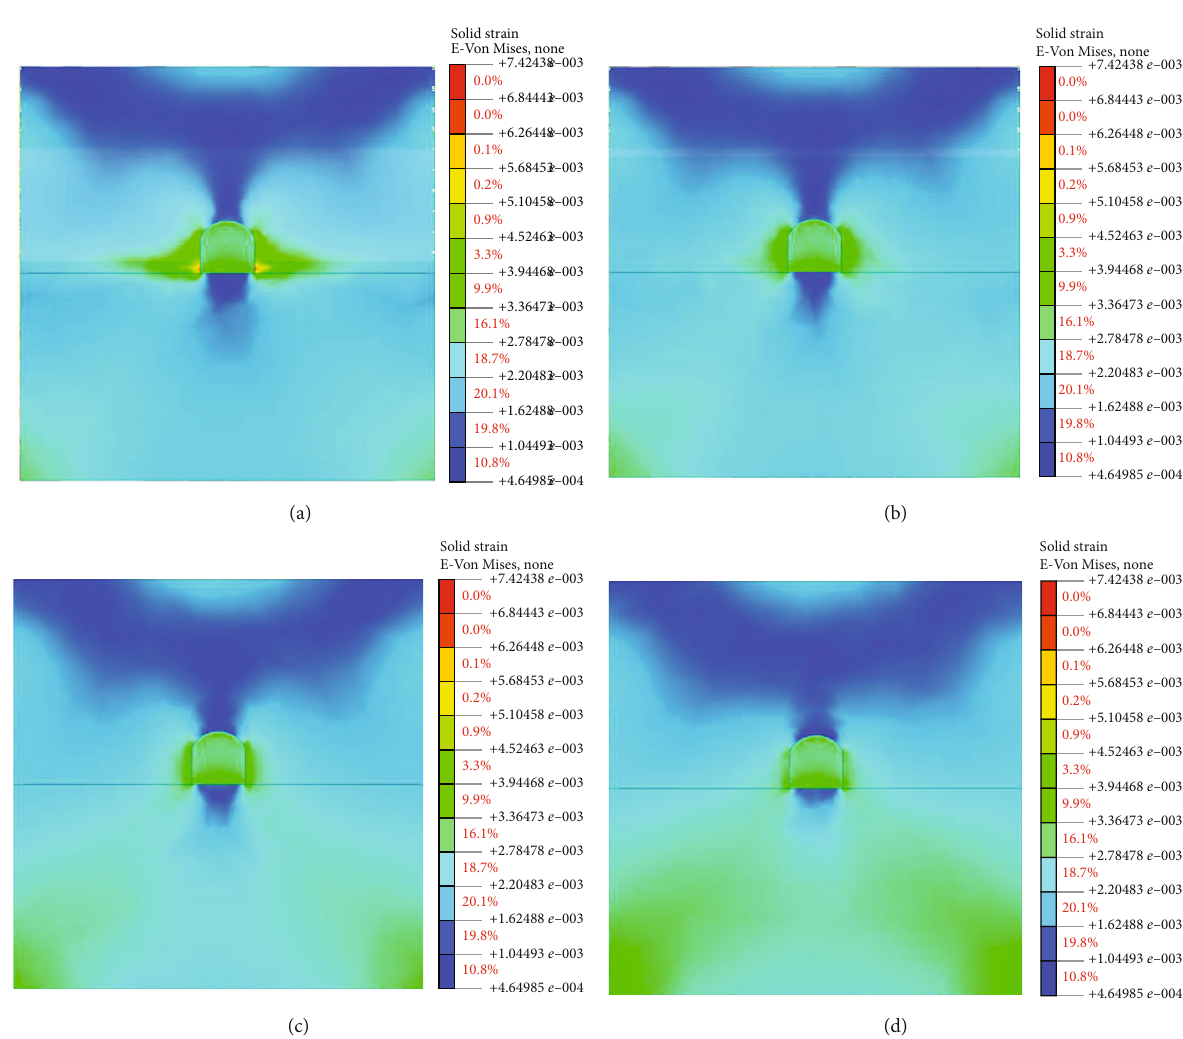
Figure 13: Strain nephograms on each cross-section of cave dwelling under 0.10 g: (a) at 0.1 m from entrance to the cave; (b) at 1 m from entrance to the cave; (c) at 3 m from entrance to the cave; (d) at 6 m from entrance to the